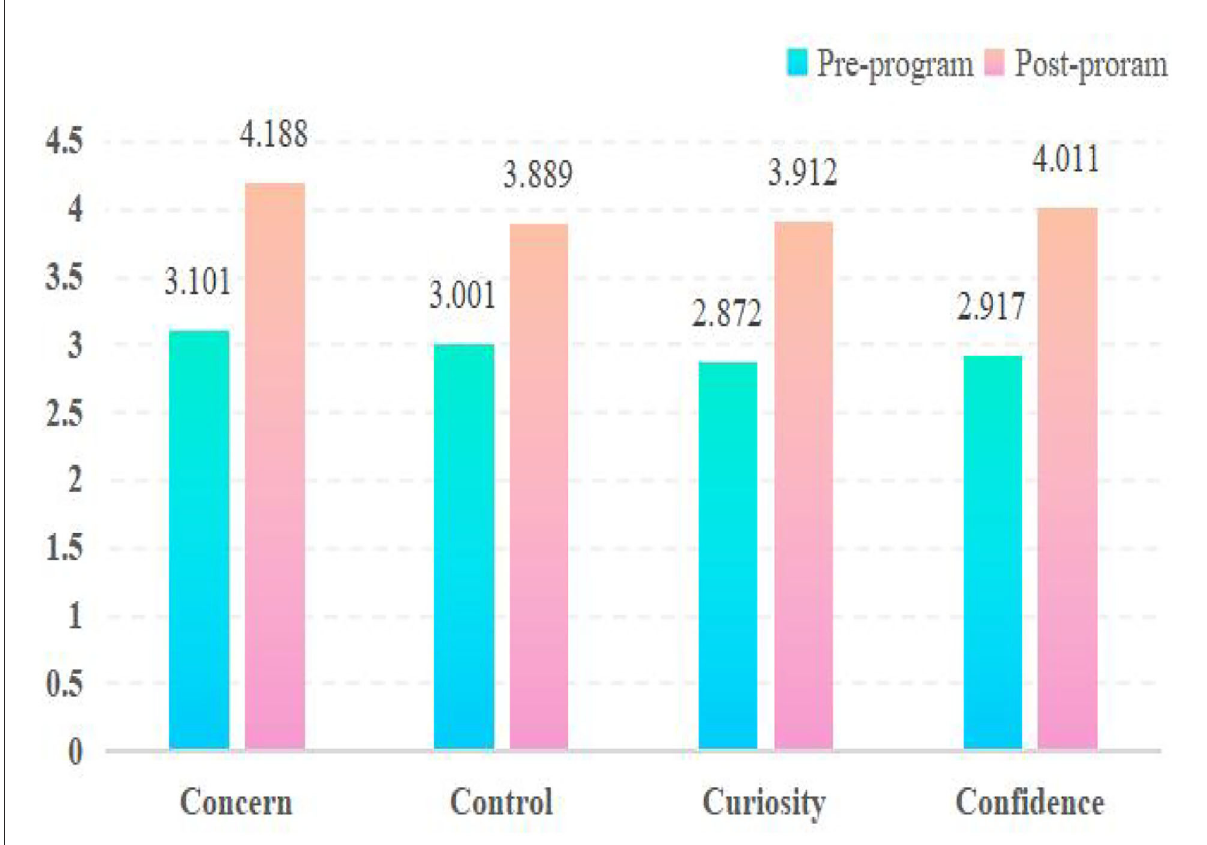
FIGURE2 Pre-/post-program mean values for four CAAS second-order adaptability